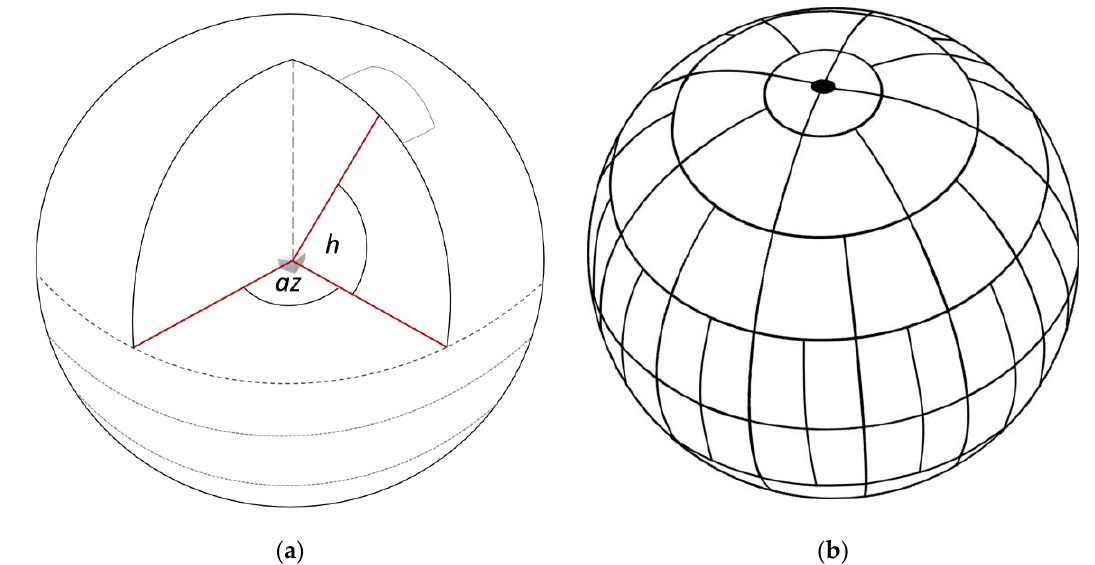
Figure 1. View sphere for an exemplary grid cell to be analyzed depicting azimuthal angle az and height angle h definition ( a ) and individual view facet distribution per height angle ( b ) showing that view facet count decreases with increased height angles.